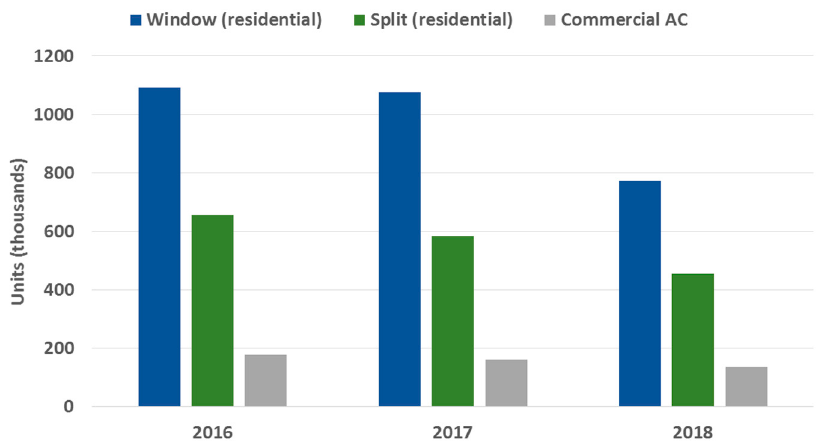
Figure 3. Saudi Arabian AC demand by unit type (2016–2018) Source: Japan Refrigeration and AC Industry Association.